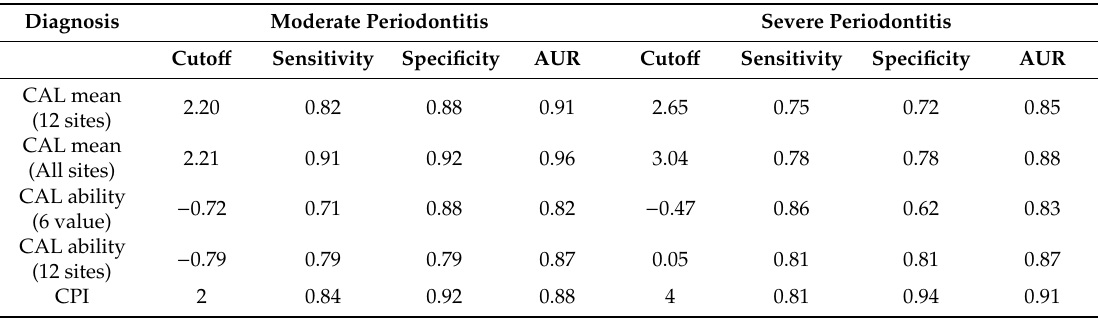
Table 3. Receiver operating characteristic analysis for the selected optimal examination sites for the diagnosis of periodontal